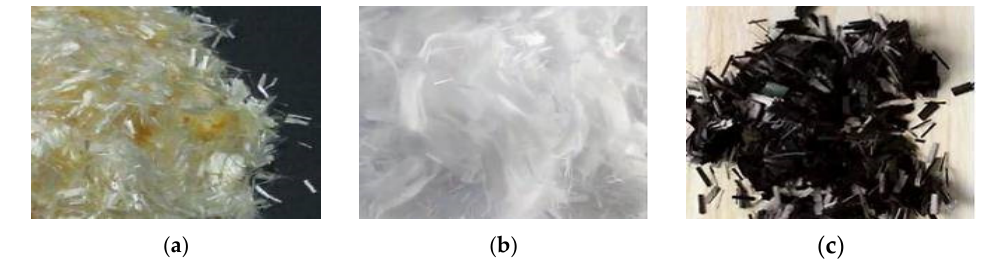
Table 2. Particle size gradation.